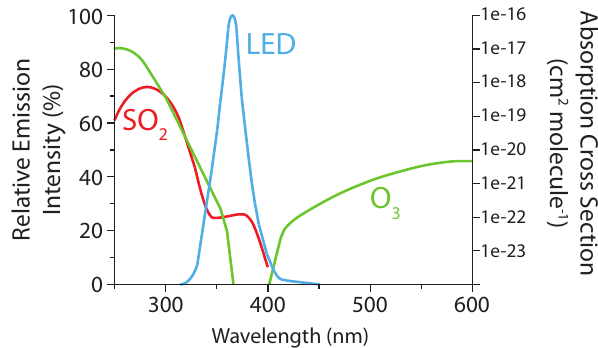
Fig. 2. Emission spectrum of LED used to irradiate mineral dust samples (blue line, left axis, Roithner (2011)) and absorption spec- tra of SO 2 (red line, right axis, Rufus et al., 2003) and O 3 (green line, right axis, Bogumil et al.,